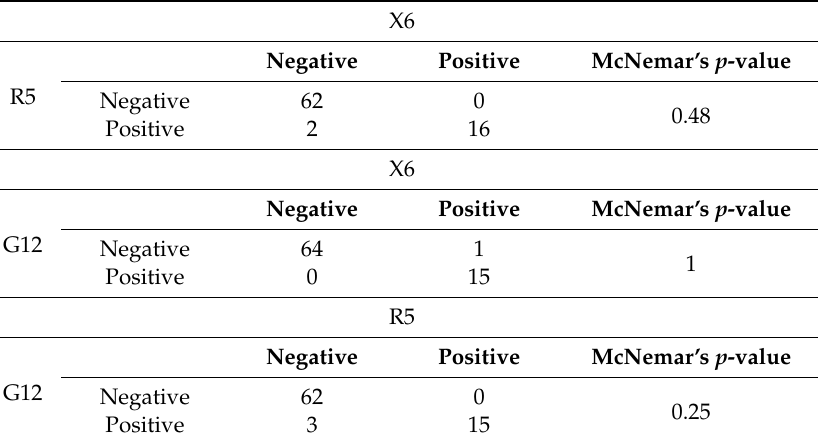
Table 7. McNemar’s test for all samples ( n = 80).